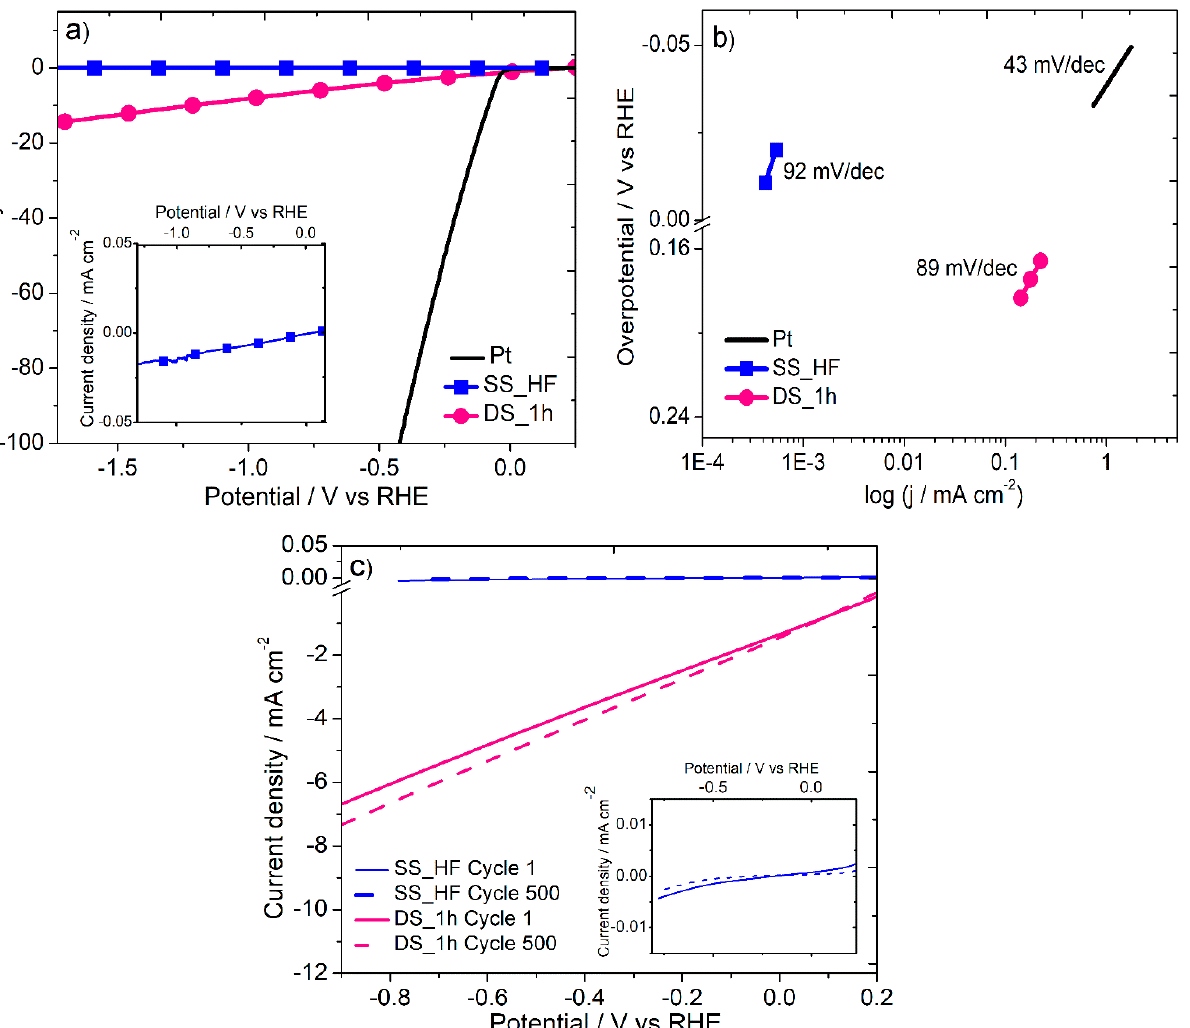
Figure 11. For pure Pt (solid black line), SS_HF (blue line with cubes) and DS_1h (dotted pink line) ( a ) linear sweep voltammetry (LSV) polarisation curves, inset shows the magnified view of the curve for SS_HF; ( b ) Tafel slope; and ( c ) LSV polarization curves after 500 cycles of potential scans for SS_HF and DS_1h, inset shows the magnified view of the curves for SS_HF.